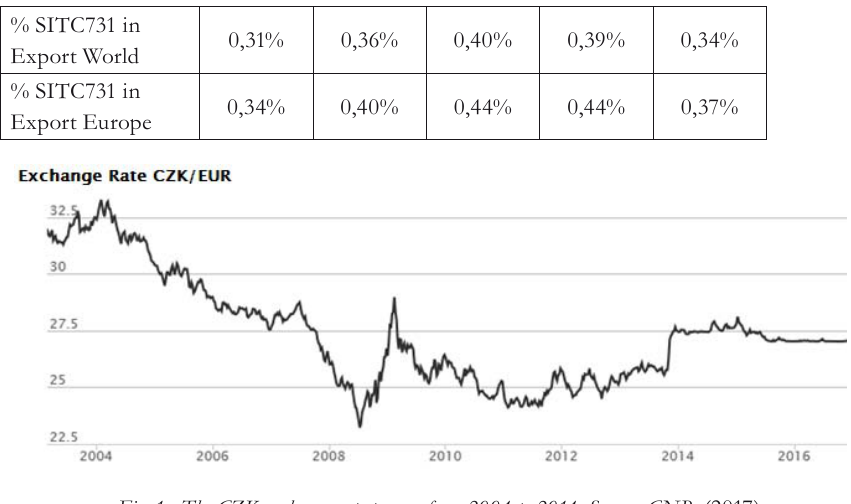
Fig. 1 - The CZK exchange rate to euro from 2004 to 2014. Source: CNB, (2017)